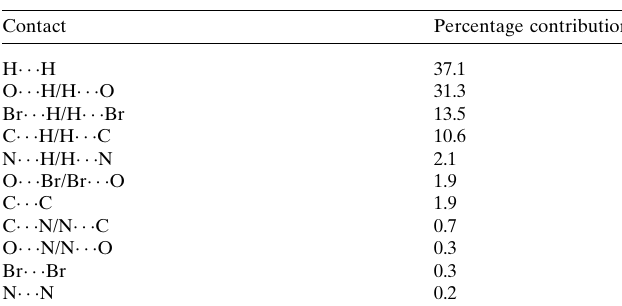
Table 2 Percentage contributions of interatomic contacts to the Hirshfeld surface of the title compound.